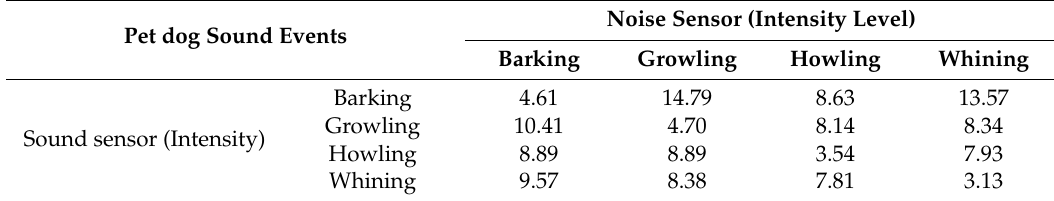
Table 2. The results of RMSE between intensity and intensity level.